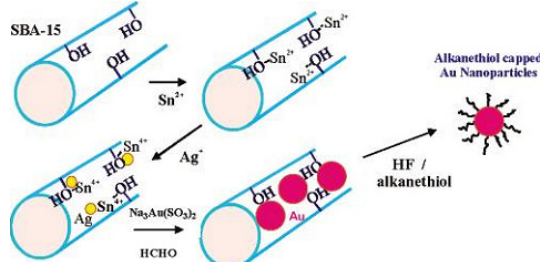
Figure 13. Scheme of electroless synthesis Au/SBA-15 and alkanethiol-capped gold nanoparticles. Reproduced with permission from [46]. Copyright 2005 American Chemical